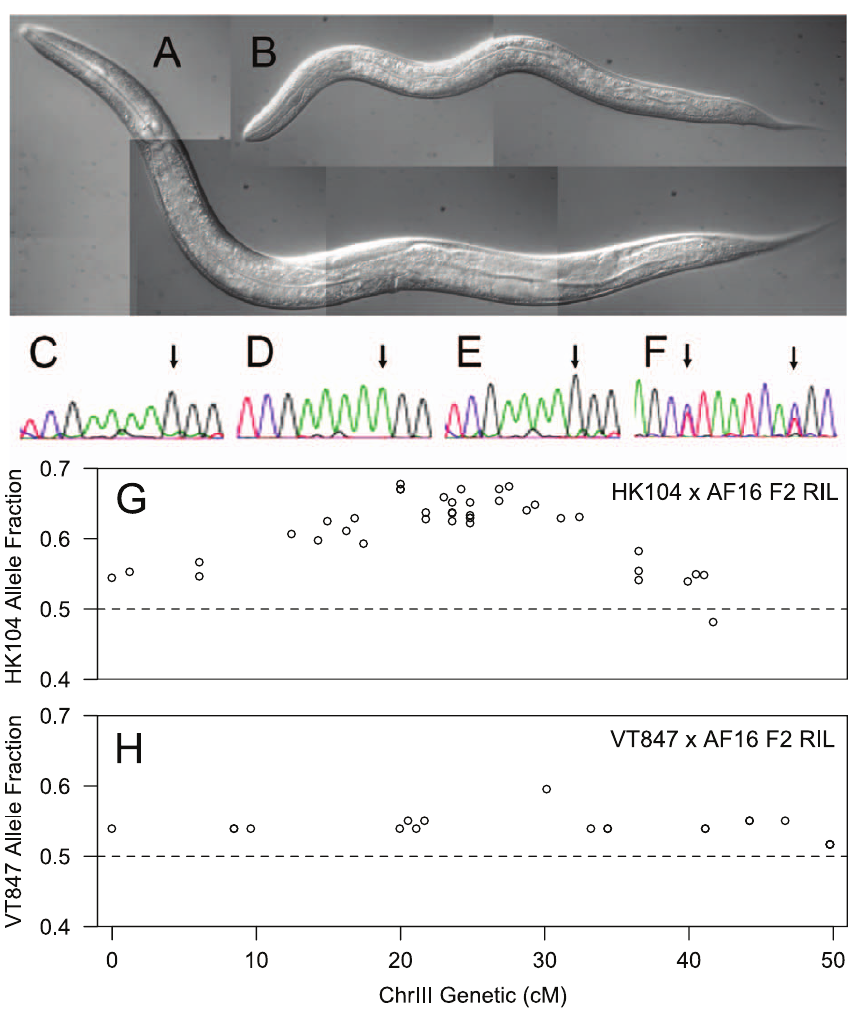
Figure 5. F2 slow-growth phenotype is linked to ChrIII. A,B) DIC micrographs, taken at the same magnification 48 hours after egg laying by an AF16/HK104 hybrid F1 hermaphrodite, of A) an adult non-delayed F2 and B) an L2 delayed F2 sibling. C–F) Sequence traces from Cbr-egl-5 (CBG0023, ChrIII:12.2 Mbp) amplification products derived from pools of C) 50 AF16 individuals, D) 50 HK104 individuals and E) 50 delayed F2 hybrids show the biased segregation of AF16 alleles on ChrIII with the F2 delay phenotype. Arrows indicate the position of the polymorphic nucleotide in the TCGAAA[G/A]GG sequence. Similar results were obtained for Cbr-glp-1 (CBG06809, ChrIII: 10.1 Mbp) (data not shown). F) A sequence trace shows two linked control SNPs from Cbr-mab-20 (CBG22137, ChrI: 2.5 Mbp) amplification products derived from pools of 50 delayed F2 hybrids and demonstrates the unbiased segregation in delayed F2s of both AF16 and HK104 alleles on a different autosome. The arrows indicate the positions of the polymorphic nucleotides in the AGC[C/T]TAATCA[C/T]GC sequence. G,H) Comparison of ChrIII marker transmission ratios for two F2 RILs: G) HK104 allele fraction for all ChrIII markers mapped in the HK104 6 AF16 F2 RIL in [38] shows greater deviation from the expected value of 0.5 than seen in H), the VT847 allele fraction on ChrIII in the VT847 6 AF16 F2